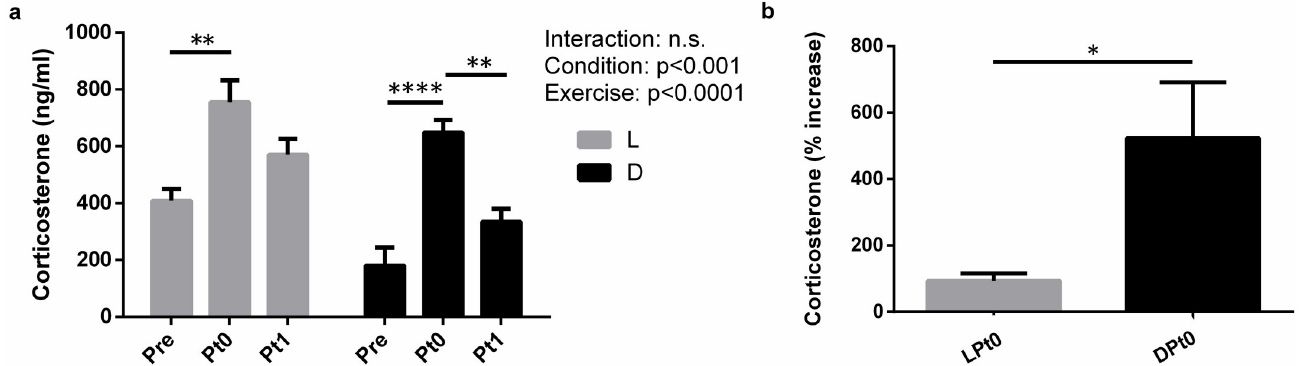
Fig 4. Increased rate of serum corticosterone immediately after eccentric exercise. Serum corticosterone concentration (a), rate of increase in serum corticosterone (b). L, light phase; D, dark phase. Values are the mean ± standard error (SE); n = 7 per group. The results of the two-way analysis of variance (ANOVA) are displayed in a. The results of the unpaired t-test are displayed in b. � P < 0.05, �� P < 0.01, ���� P < 0.0001.